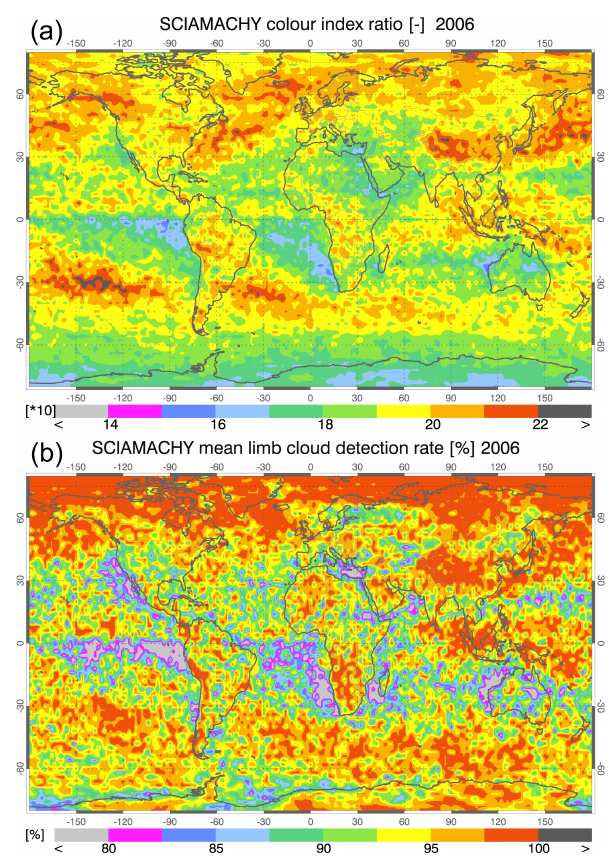
Figure 8. Global annual mean of (a) the maximum colour index ratio and (b) the limb cloud detection rate for 2006. The CIR is multiplied by a factor of